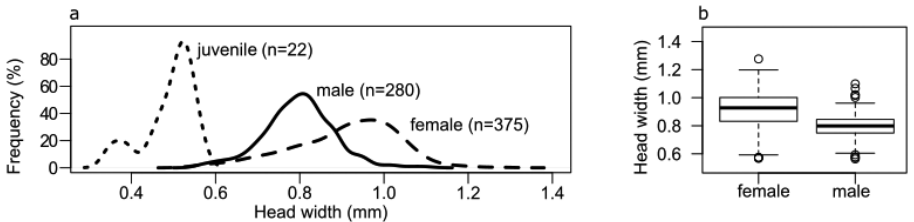
Figure 3. a Frequency of size distribution of the studied Mesoniscus graniger population by gender and age b Significant differences in head width distribution (average ± SE) of the sexes (Welch test; p-value <0.001).